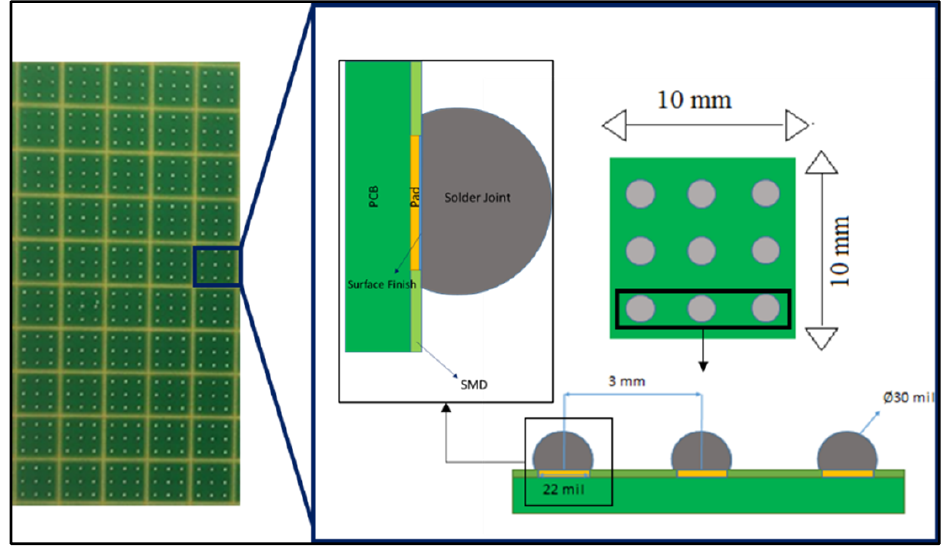
Figure 1. Test vehicle.